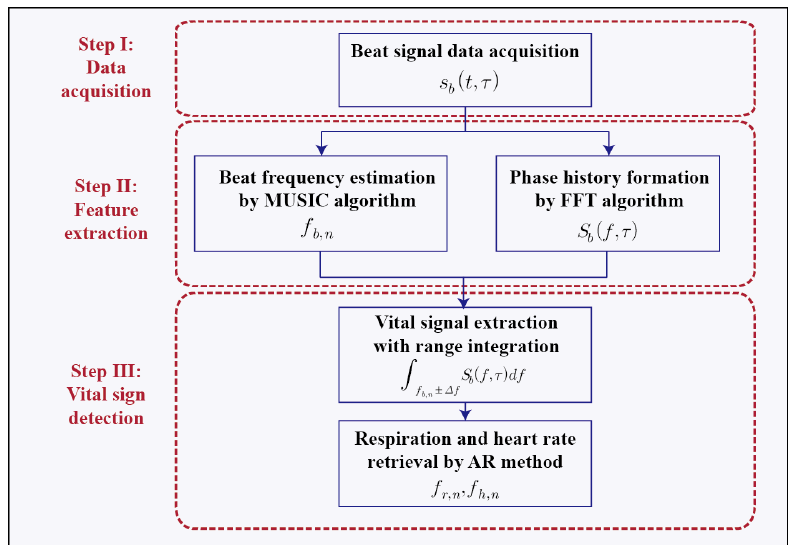
Figure 1. Flow chart of the proposed algorithm: ( I ) data acquisition from the radar system; ( II ) feature extraction for range and phase information in parallel; and ( III ) tracking vital